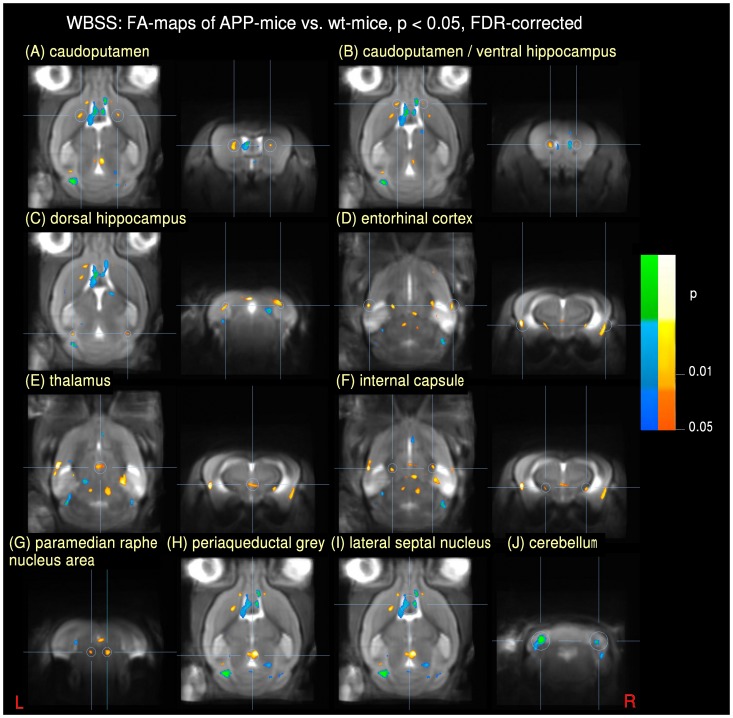
Results from whole brain-based spatial statistics (WBSS) of FA-maps of APP mice vs. wt mice at p<0.05, FDR corrected (axial and/or coronal views).Increase is displayed in cold colors, reduction is displayed in hot colors. (A) bihemispheric reduction in the caudoputamen; (B) bihemispheric reduction in the caudoputamen/ventral hippocampus; (C) bihemispheric reduction in the dorsal hippocampus; (D) bihemispheric reduction in the entorhinal cortex; (E) reduction in the thalamus; (F) bihemispheric reduction in the internal capsule; (G) reduction in the paramedian raphe nucleus area; (H) reduction in the periaqueductal grey/dorsal raphe nucleus; (I) increase in the lateral septal nucleus area; (J) bihemispheric increase in the cerebellum.